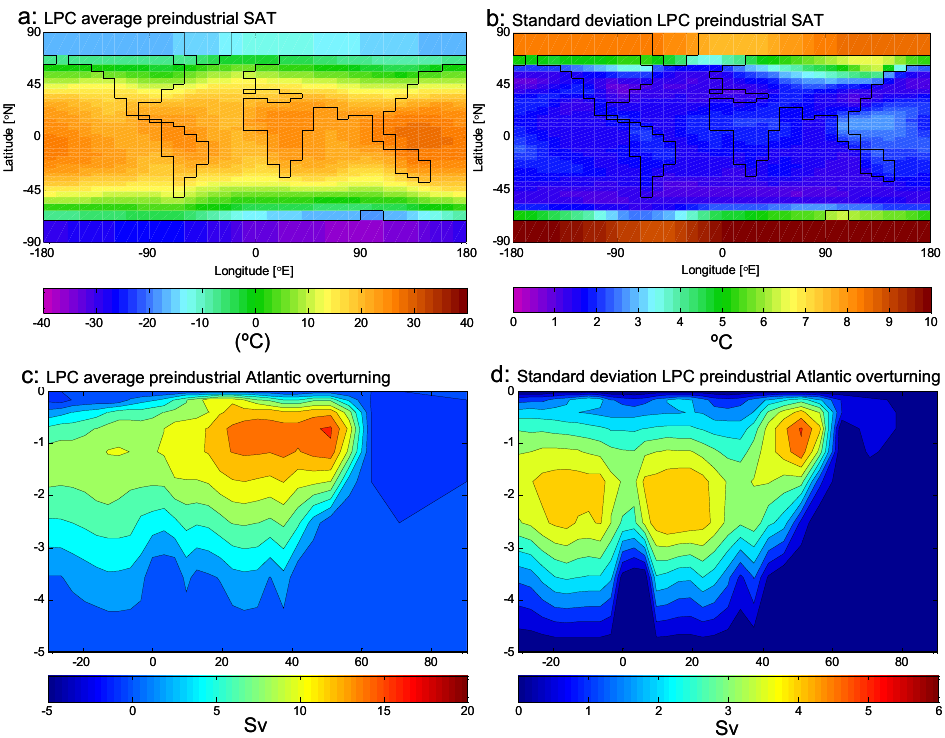
Fig. 2. Ensemble average and standard deviation of preindustrial (a, b) SAT ( ◦ C) and (c, d) Atlantic overturning stream function (Sv). Data are derived from the LPC (LGM Plausibility Constrained) parameter set (Holden et al.,